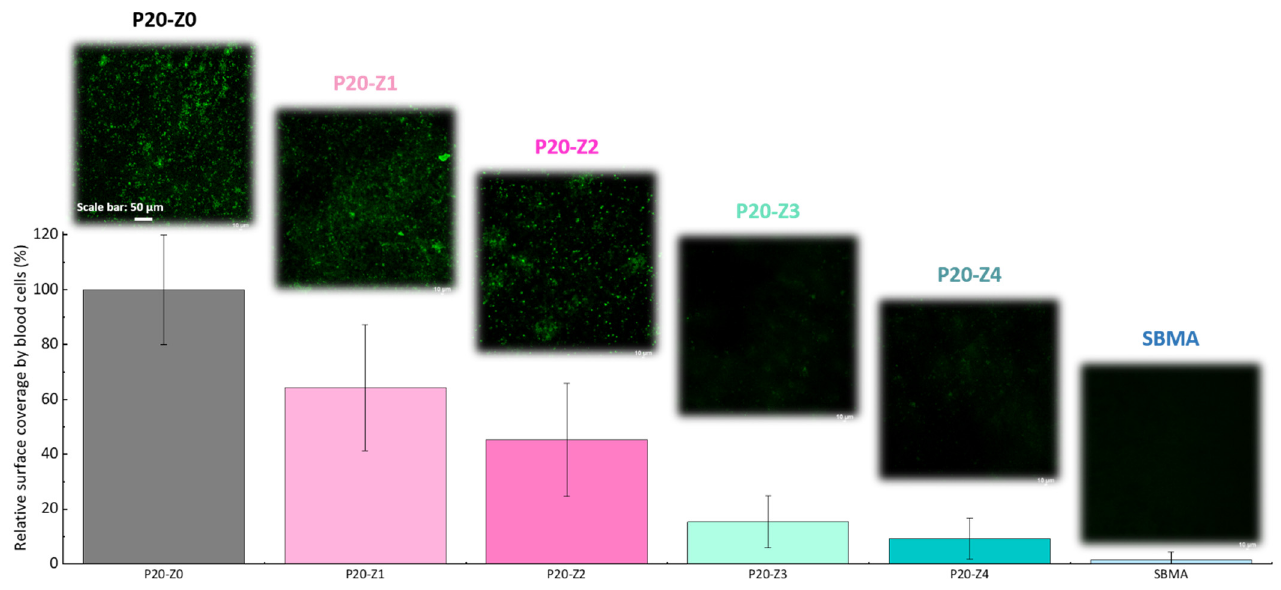
Figure 10. Effect of zwitterionic copolymer on the resistance of membranes to the attachment of cells from whole blood.